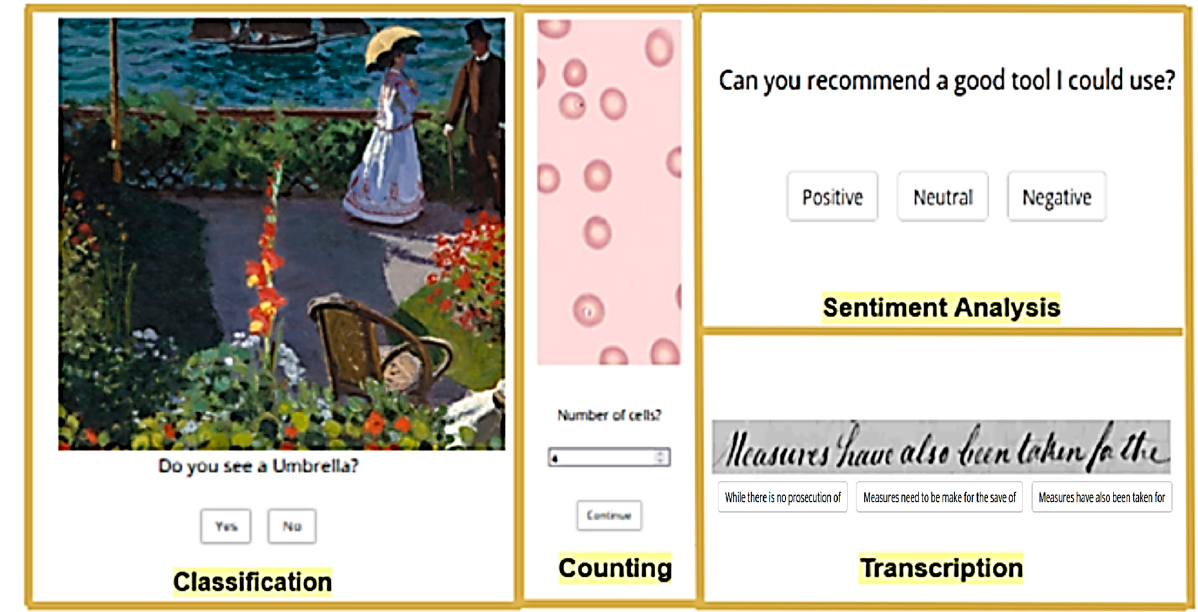
Figure 1. UI of microtasks (classification, counting, sentiment analysis, and transcription) with personalization developed for the case study.